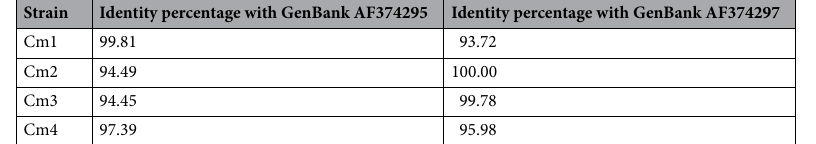
Table 3. BLASTn identity values of the consensus obtained for C. maltaromaticum